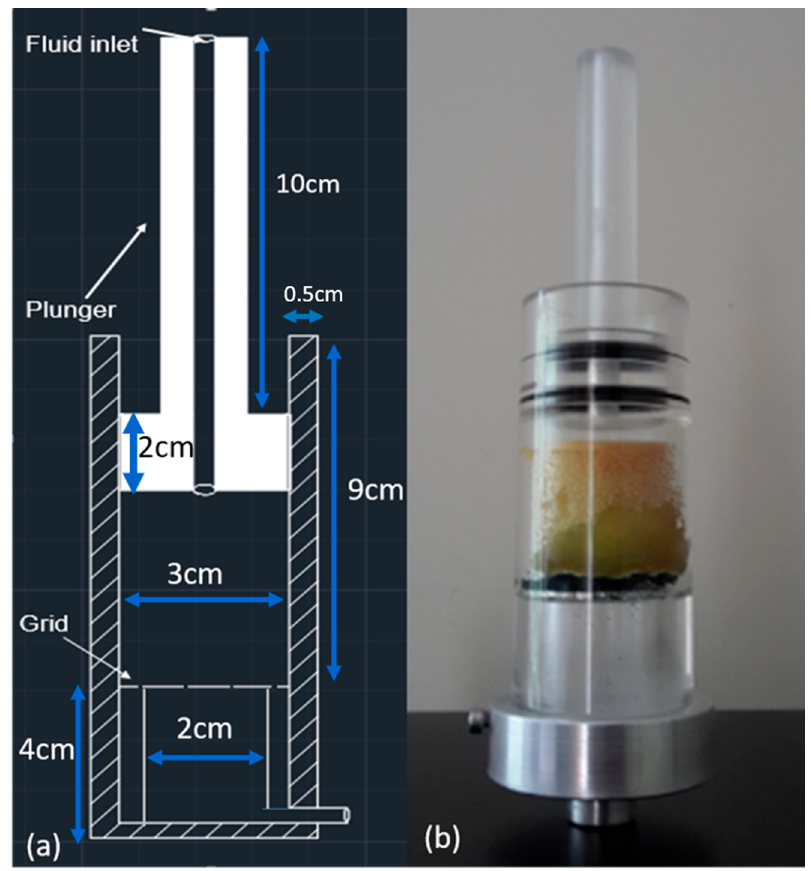
Figure 1. ( a ) 2D front view of CAD model of the sample holder (not to scale), ( b ) photo of the sample holder with sponge.